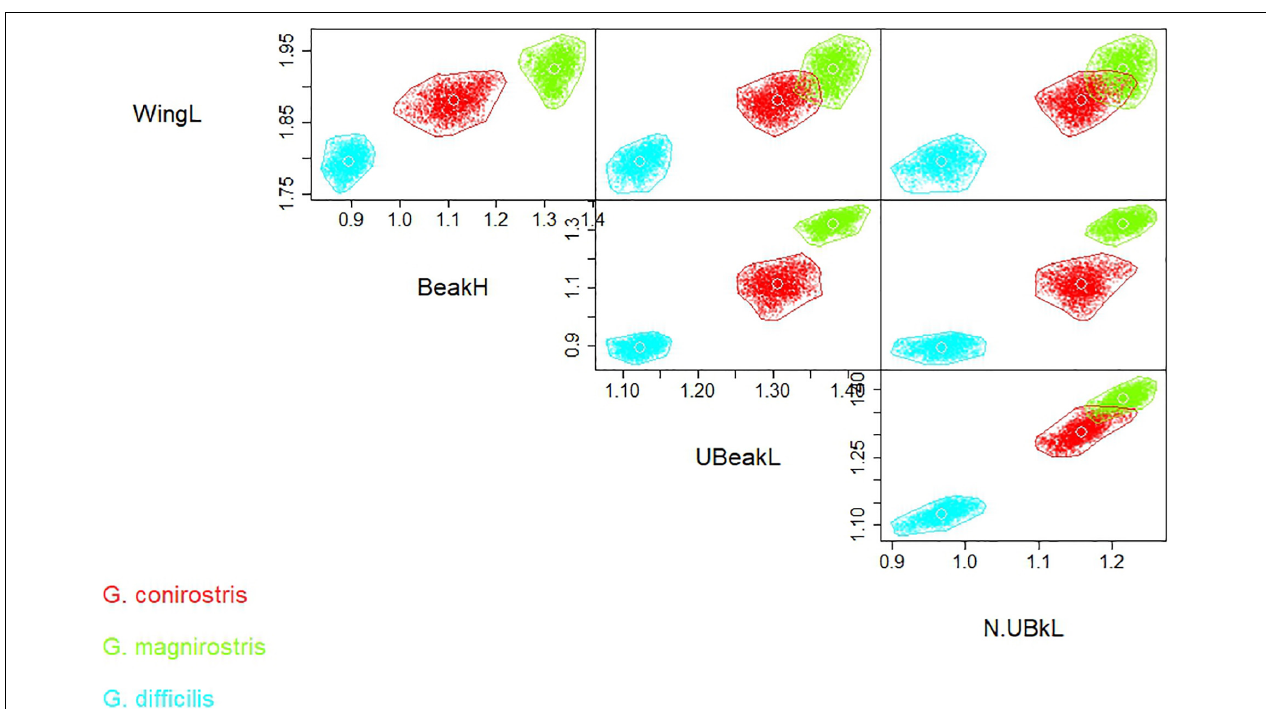
FIGURE 3 | Niche partitioning for three species of Darwin’s finches Geospiza conirostris , Geospiza magnirostris, and Geospiza difficilis for Genovesa Island. Hypervolumes shown as 2D projections for all combinations of trait axis (WingL, wing length; BeakH, Beak height; UbeakL, upper beak length and N-UBkL, nostril upper beak length) after log-transformation of the original